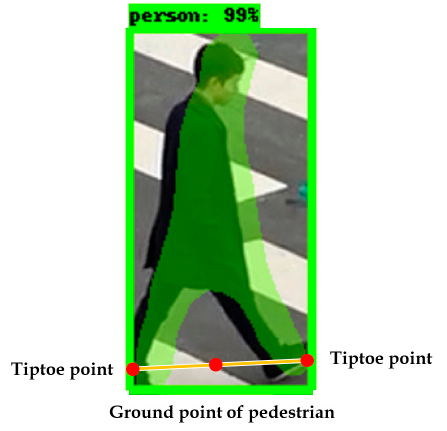
Figure 4. Ground point of pedestrian for recognizing its overhead view point.